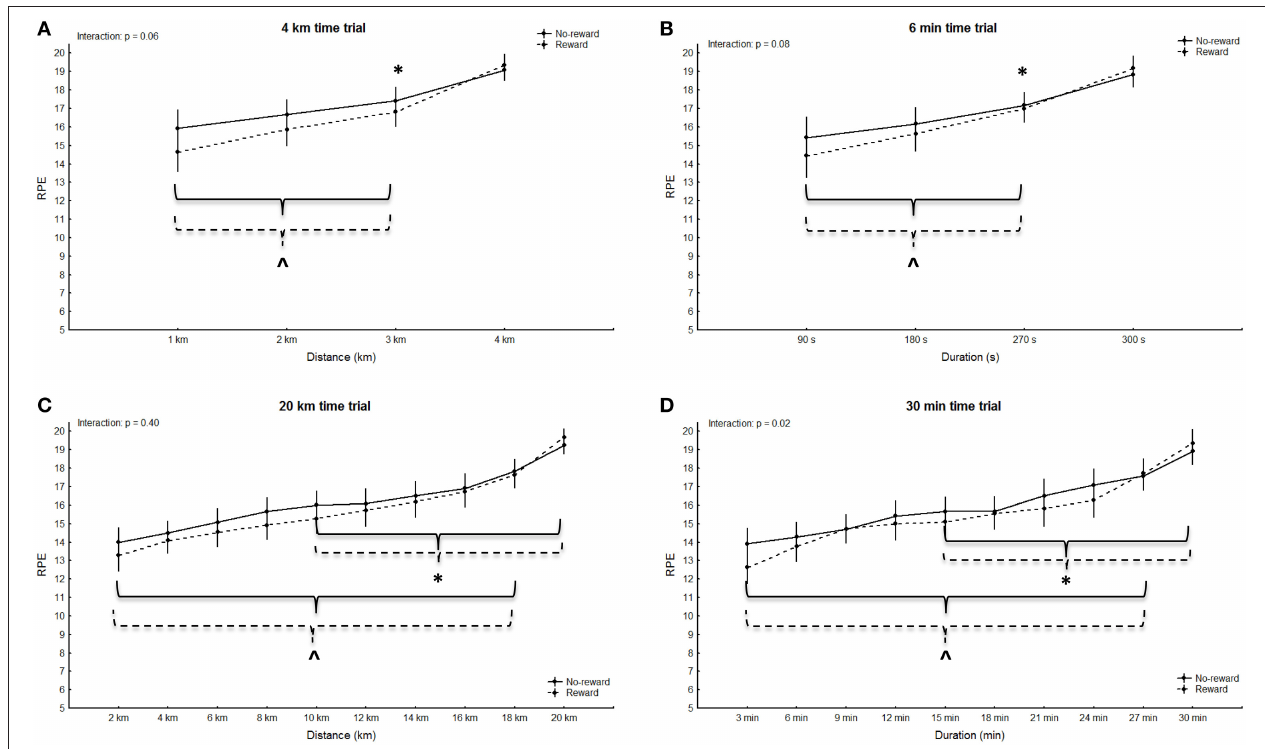
FIGURE 3 | RPE during the short (A,B) and the long trials (C,D). Means ± standard deviation. Solid line: non-rewarded; dotted line: rewarded. * indicates a significant within-trial difference to split one; ∧ indicates a significant within-trial difference to the last split; # indicates a significant effect between groups at this split.